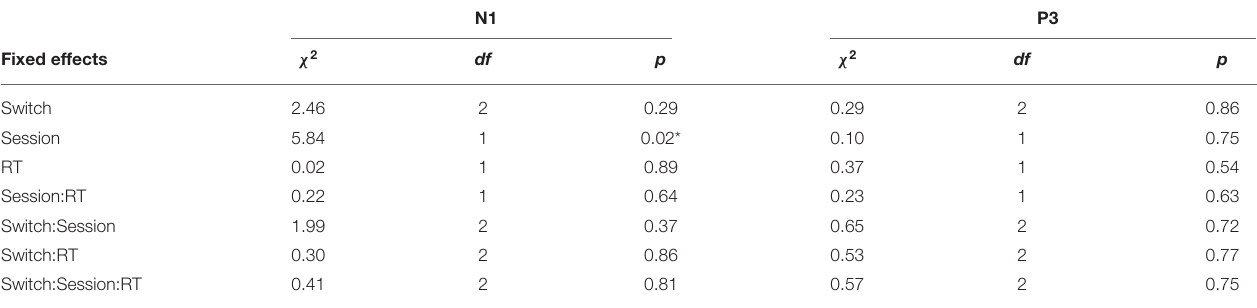
TABLE 7 | Summaries of the Wald χ 2 tests in the LMEs for EEG responses relative to feedback